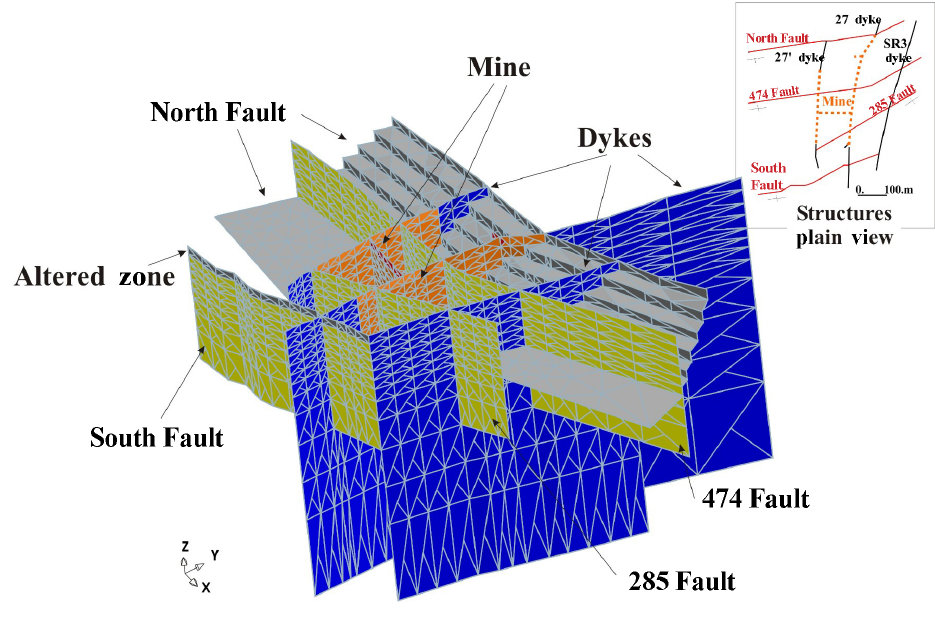
Figure 8. Main structures implemented in the model as planar structures. They are defined by 2-D elements. The model honors surface traces and dips. Downwards extension of these structures is performed with the aid of geophysics, structural geology, and intersections at boreholes. The NF is the more vertical one at its upper section, and it is cut and disconnected by faults 474 and 285 towards the south. The mine is also represented by means of 2-D elements, because it results from the exploitation of the dykes. The SF is zonated at the surface, in order to reproduce the altered zone in which the stream is embedded, where most of the water